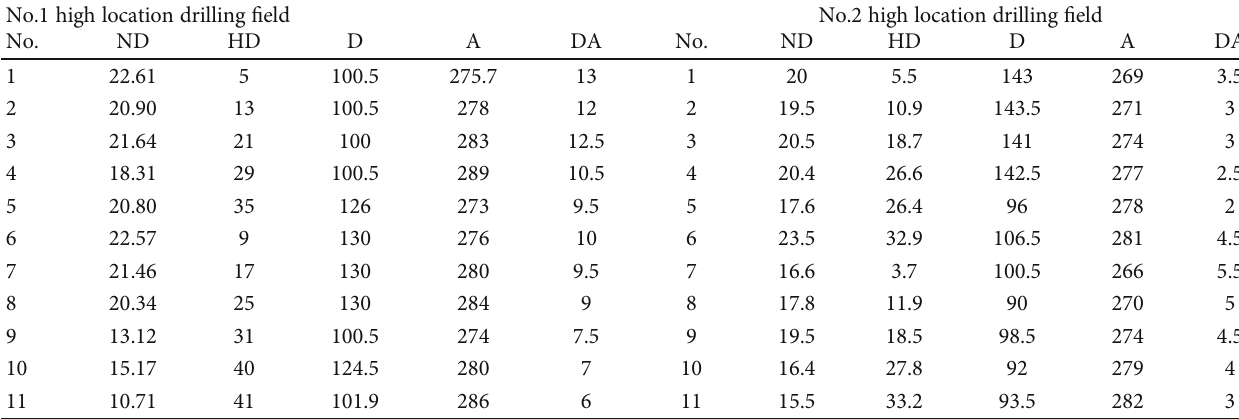
Figure 8: Layout of upper drilling fi elds. Table 3: Actual construction parameters of upper drilling fi